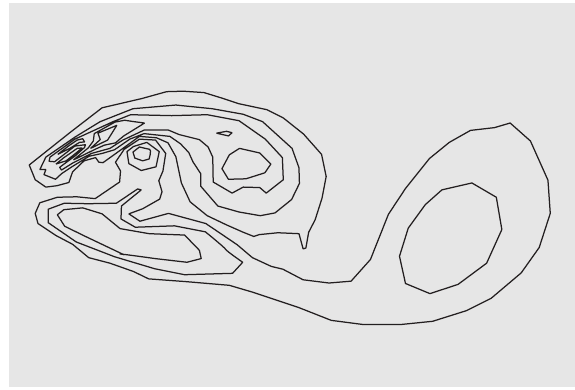
Figure 17: Surface vorticity field numerically obtained.